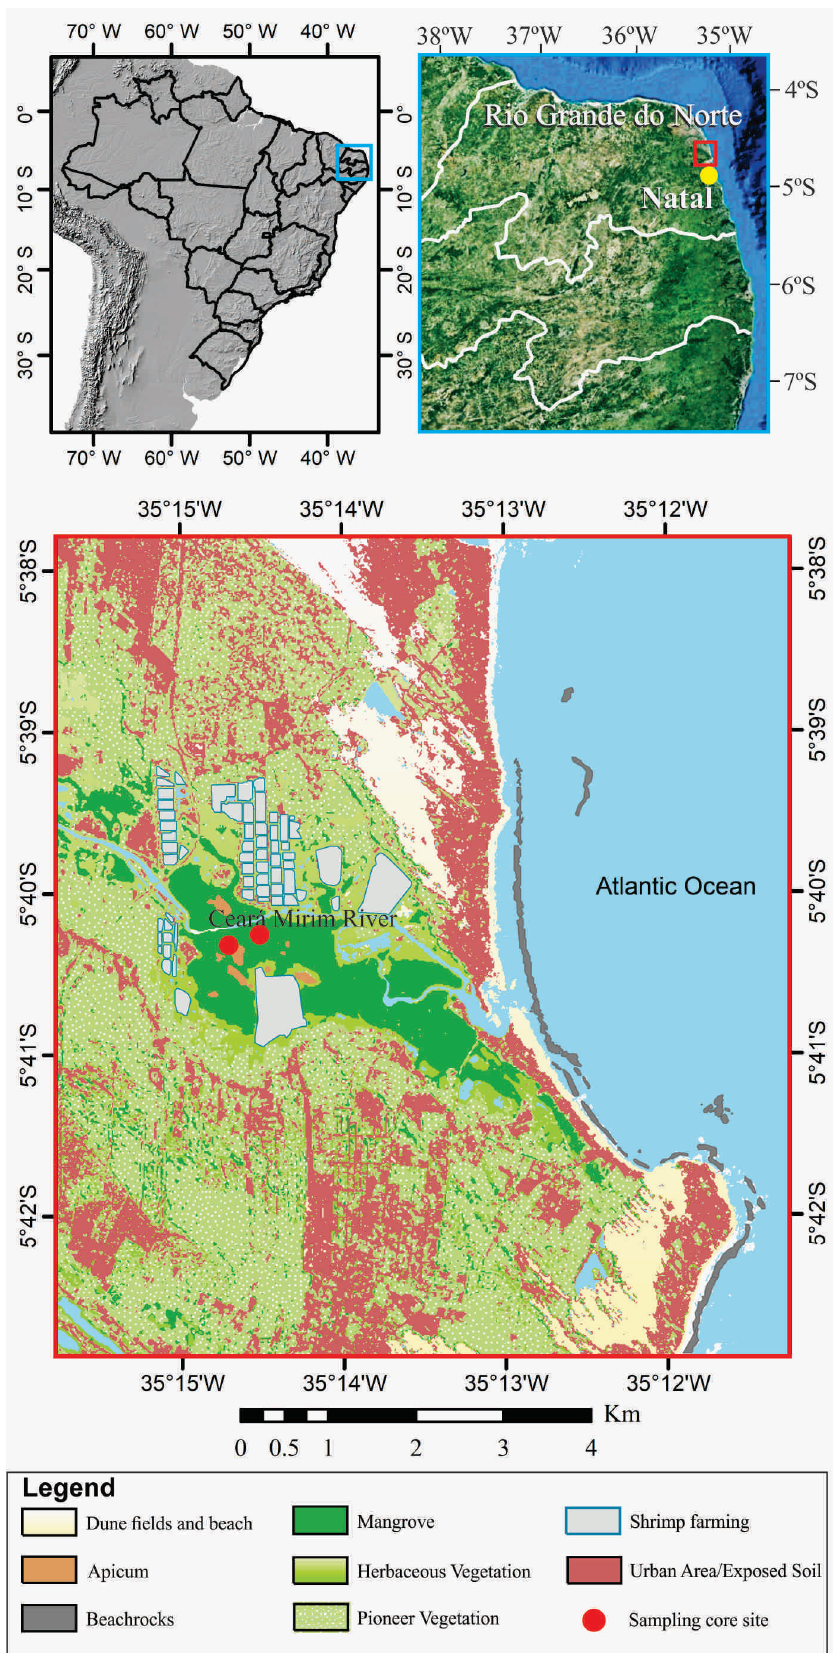
Figure 1. Location of the study area and vegetation units.